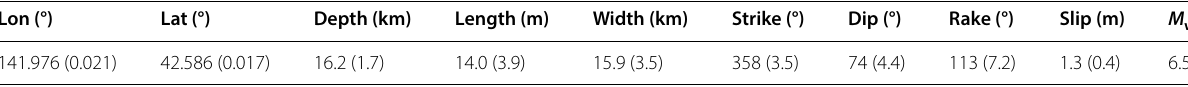
Numbers in parentheses are the standard deviations (1- σ )